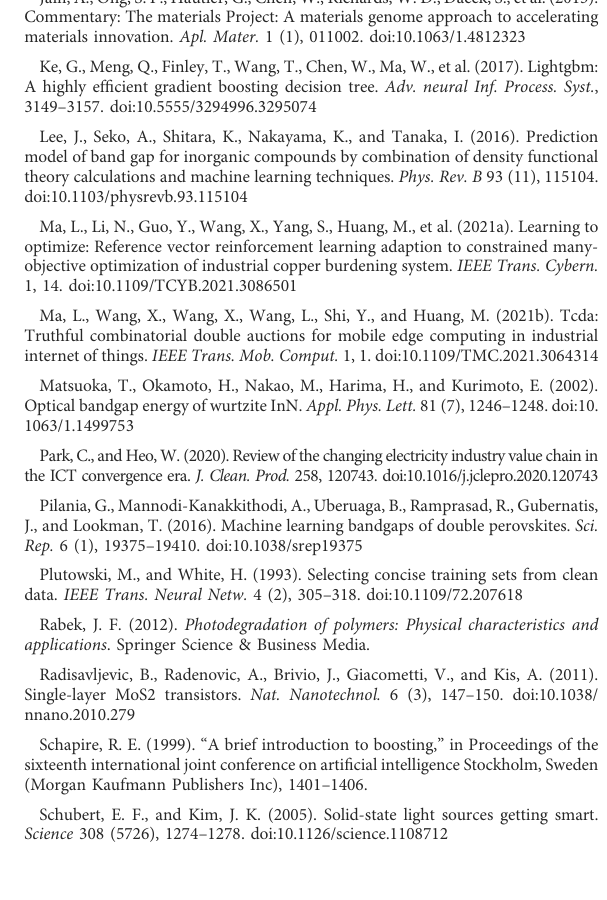
algorithm is used to fi nd the best value for the XGBoost model ’